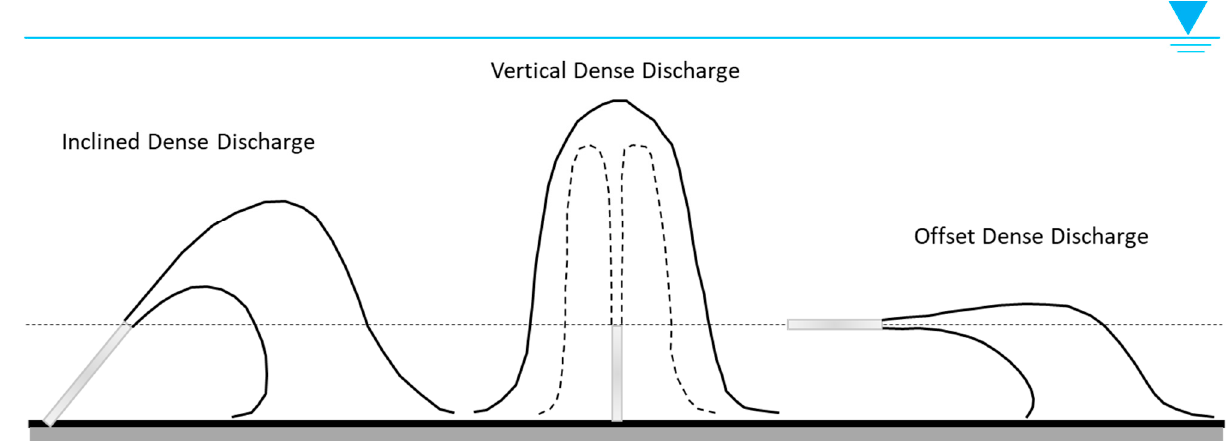
Figure 1. Dense effluent discharge configurations in deep waters.